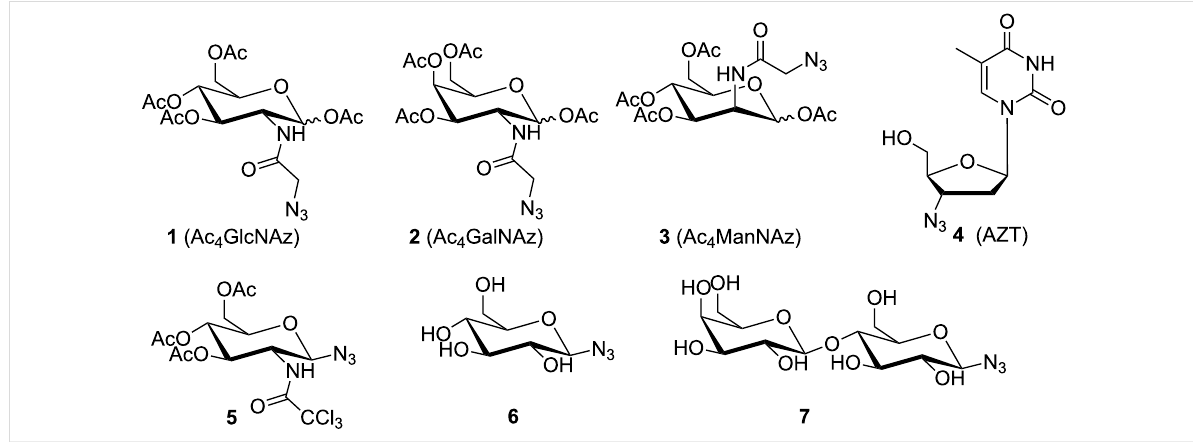
Figure 1: Azidosugars used in this study. The synthesis of the azidosugars 1 – 3 was modified from [47,48], compounds 4 , 6 and 7 were commercially available.